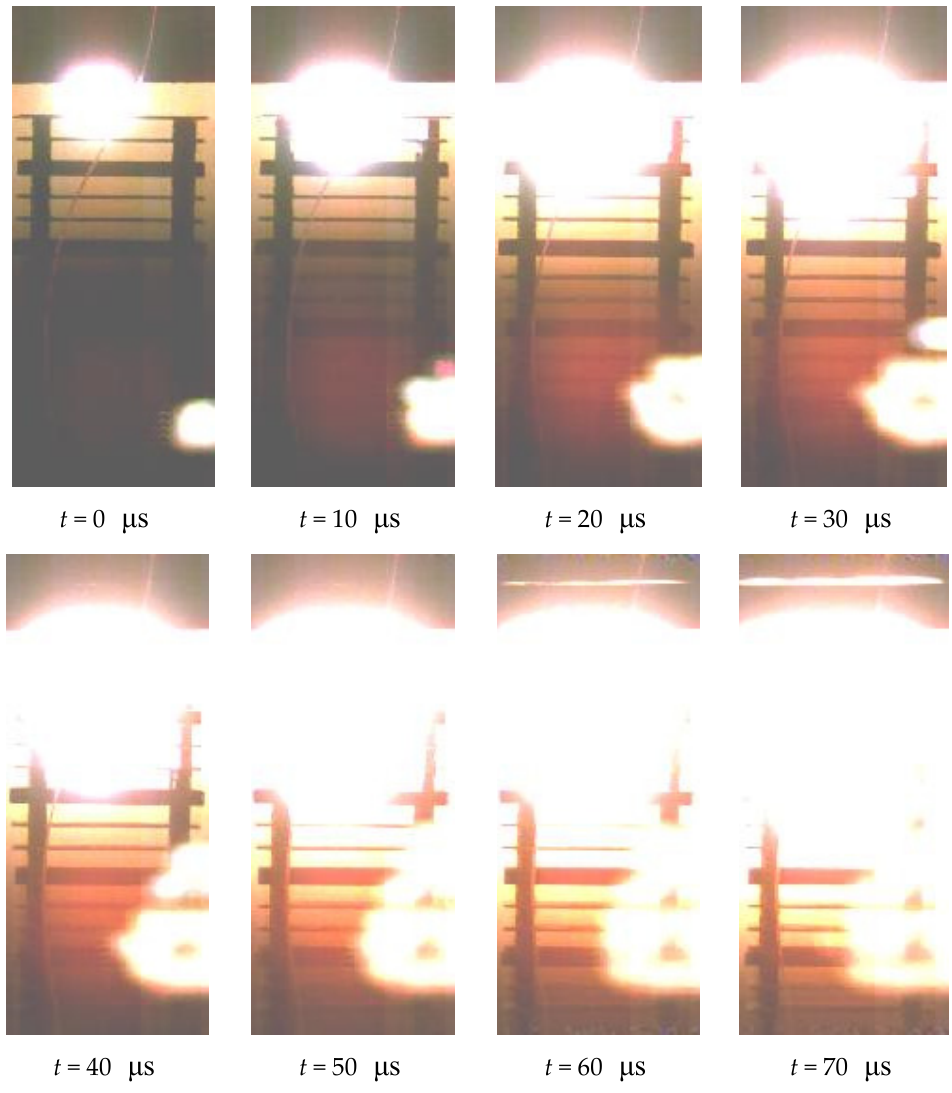
Figure 11. Photos of moving jets and firelight for design 1~3 ( a – c ). Note the light that appears at the lower right of each photo is a reflection from the bulletproof glass.